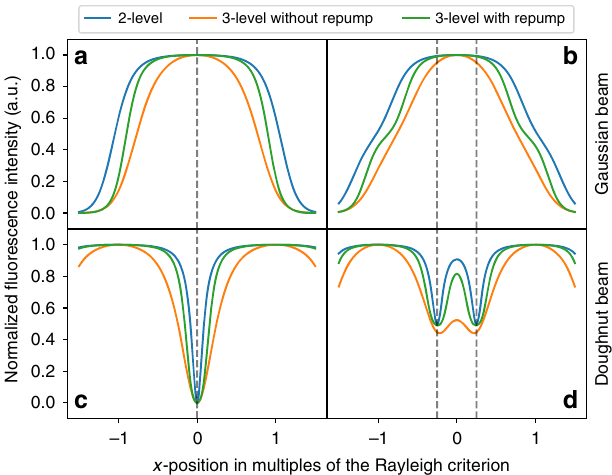
Fig. 4 Calculation of the fl uorescence pro fi le for the emitter under different laser excitations. a , b Cross-section pro fi le of a single emitter a and two closely positioned emitters b excited with a Gaussian beam. c , d Cross- section pro fi le of a single emitter c and two closely positioned emitters d excited with a doughnut beam. The blue (orange) lines correspond to emitters treated as two- (three-) level systems. The green line refers to the case where a second repumping laser is added — with Gaussian a , b and doughnut c , d pro fi le, respectively. In a – d , the x axis represents the Rayleigh criterion so that the distance between max and min of the doughnut is 1. The vertical dashed lines indicate the position of the emitter along the x